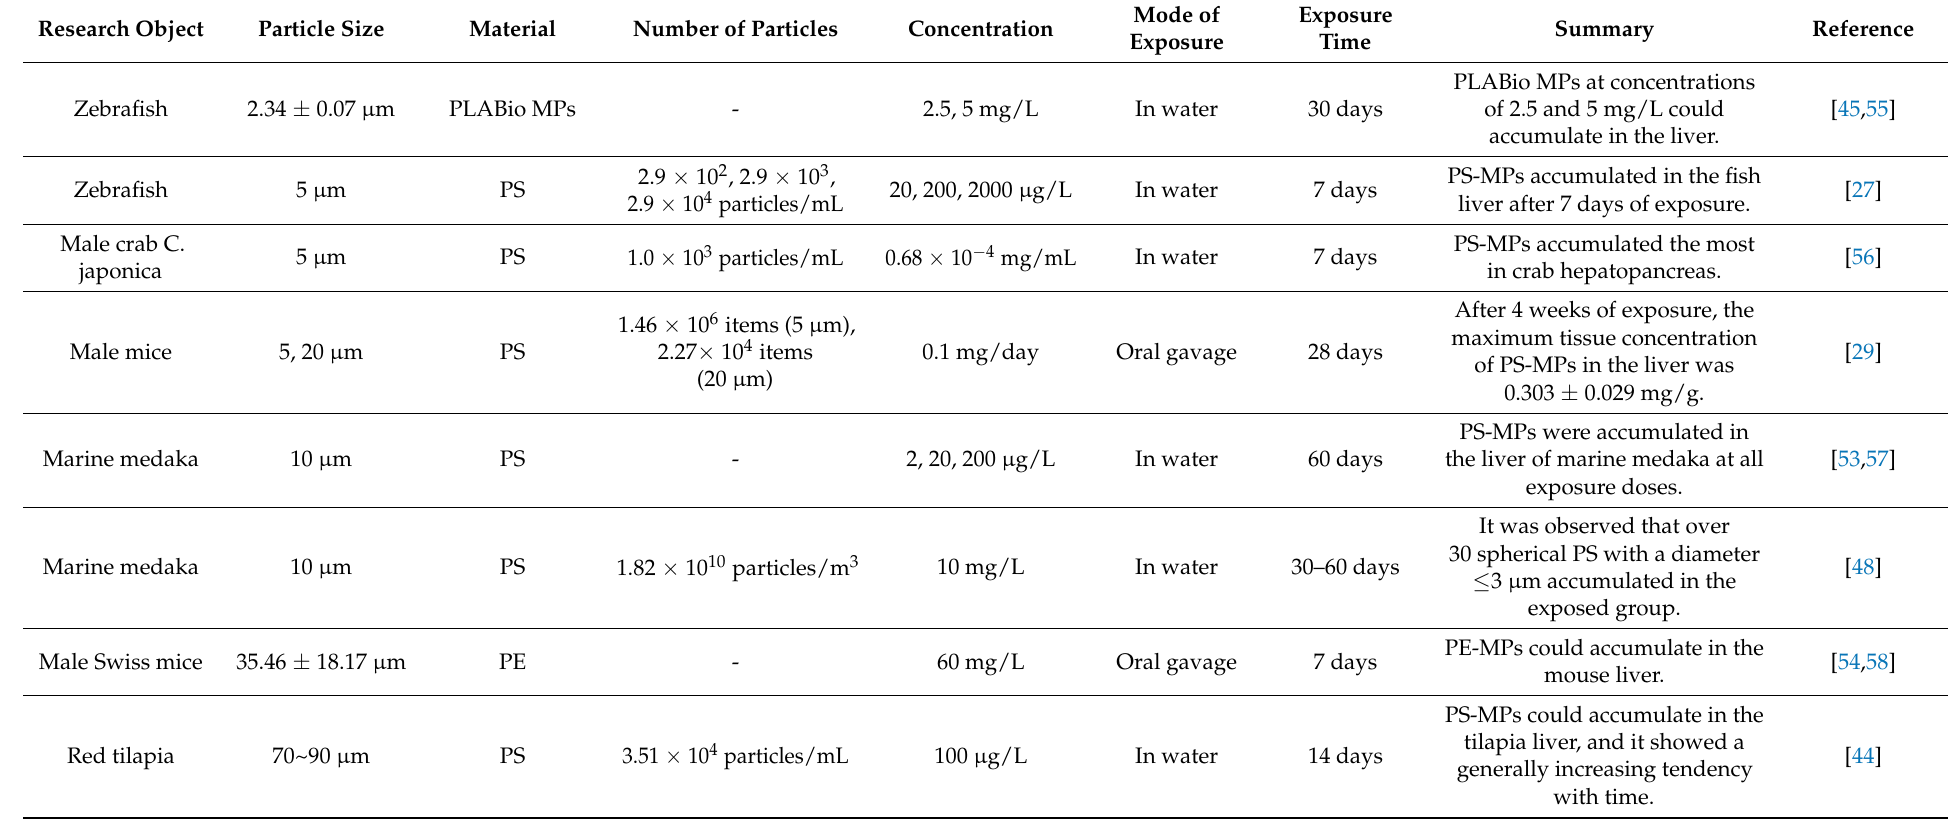
Table 2. The study parameters and effects of accumulation of MPs on the